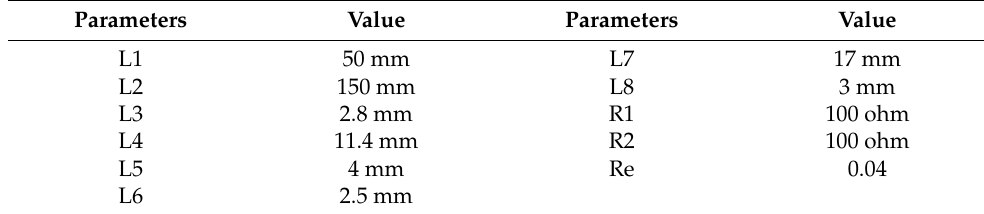
Table 1. Parameters in the Vivaldi antenna.